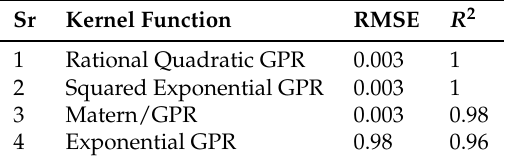
Table 4. Effect of Kernel function on developed machine learning model. Sr Kernel